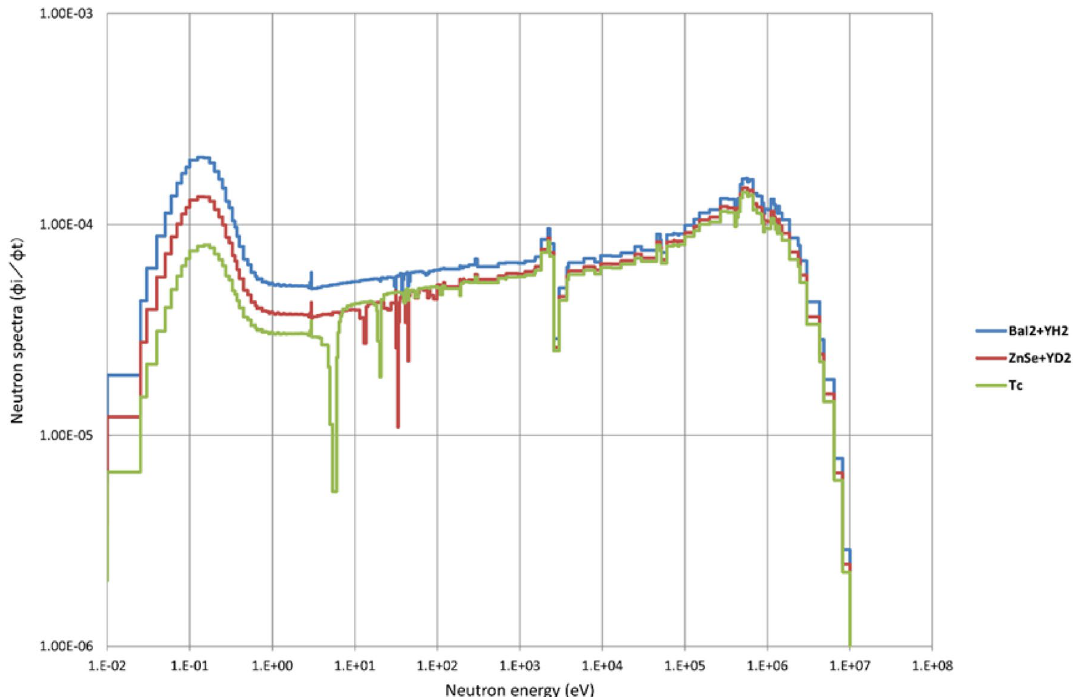
Figure 4. Neutron energy spectra in the LLFP assemblies. The neutron spectra show the cases of 129I pin (BaI 2 + YH 2 ), 99 Tc pin (Tc metal) and 79 Se pin (ZnSe + YD 2 ). The thermal neutron flux increases in the order of 129 I pin, 79 Se pin, and 99 Tc